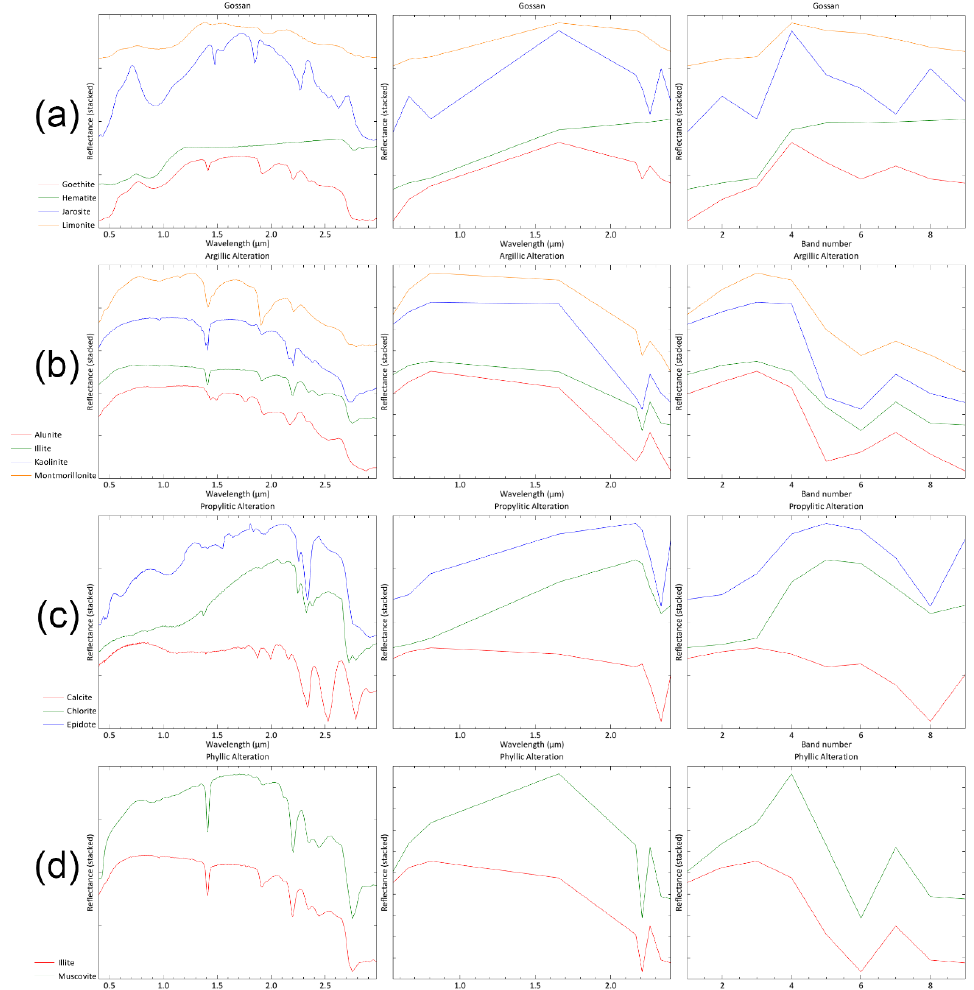
Figure 2. Laboratory spectra of the indicative minerals in ( a ) gossans, ( b ) argillic, ( c ) propylitic, and ( d ) phyllic hydrothermal alteration zones. These spectra were resampled to the advanced spaceborne thermal emission and reflection radiometer (ASTER) spectral bands and are shown against wavelength and band numbers in the second and third columns, respectively [74].